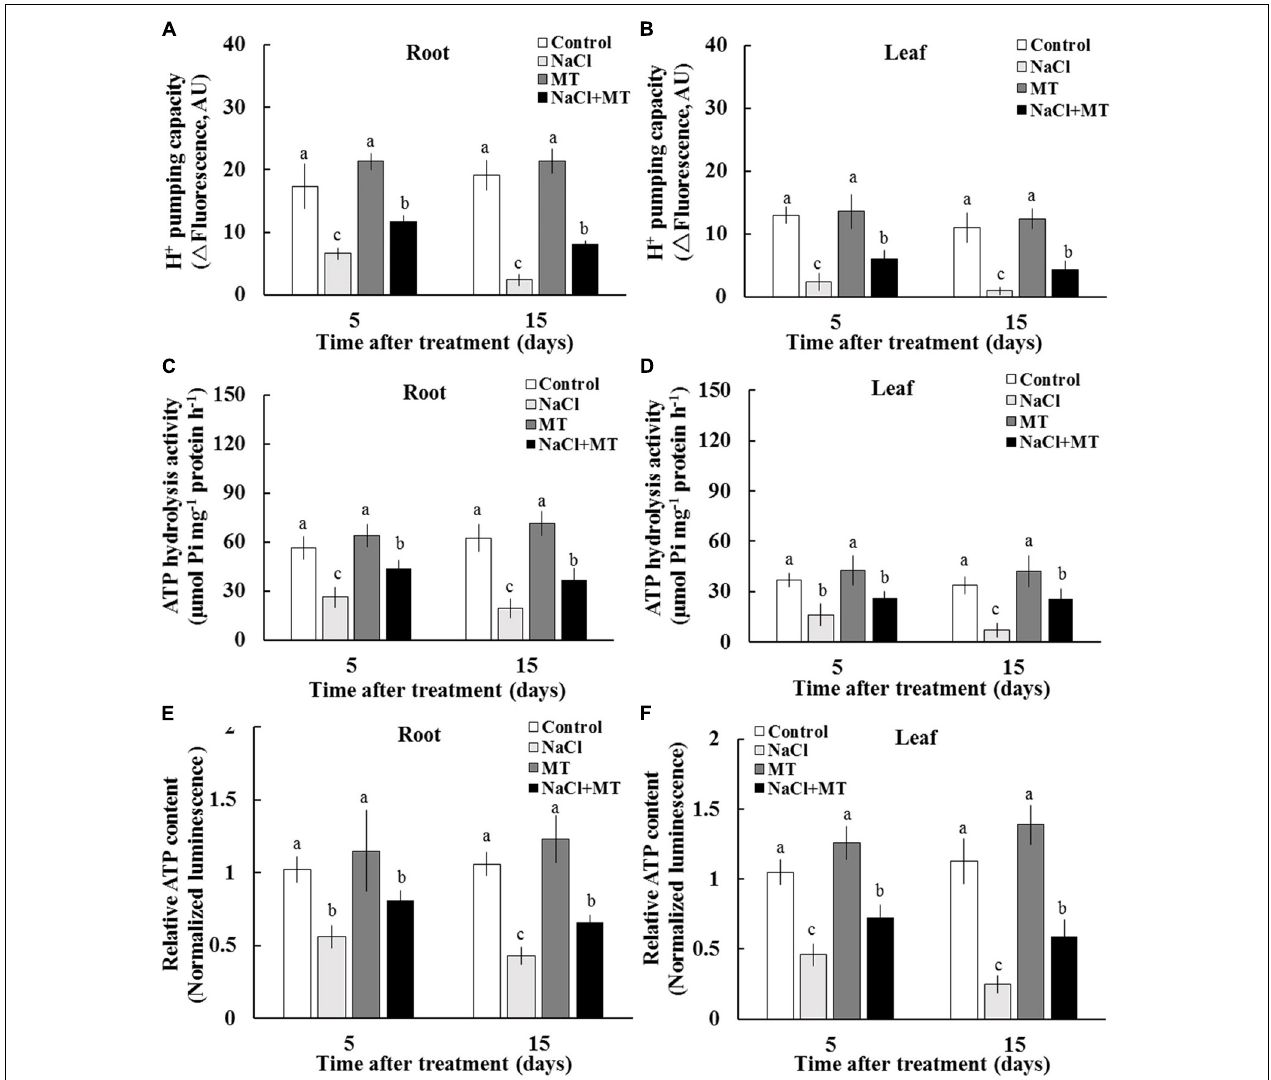
FIGURE 4 | Effects of MT on the PM H + –ATPase activity and ATP level in the root and leaf tissues of NaCl-stressed or non-stressed Xu 32. Xu 32 seedlings were pretreated with 0.5 µ M (root) + 100 µ M (leaf) MT for 3 days and then subjected to the 150 mM NaCl stress. (A,B) H + pumping activity in PM vesicles purified from the root and leaf tissues of Xu 32 after 5 and 15 days of NaCl treatment. (C,D) ATP hydrolysis activity. (A–D) Each column is the mean of three independent experiments. (E,F) Relative ATP level. Each column is the mean of six individual plants. Columns labeled with different letters indicate significant difference at P <